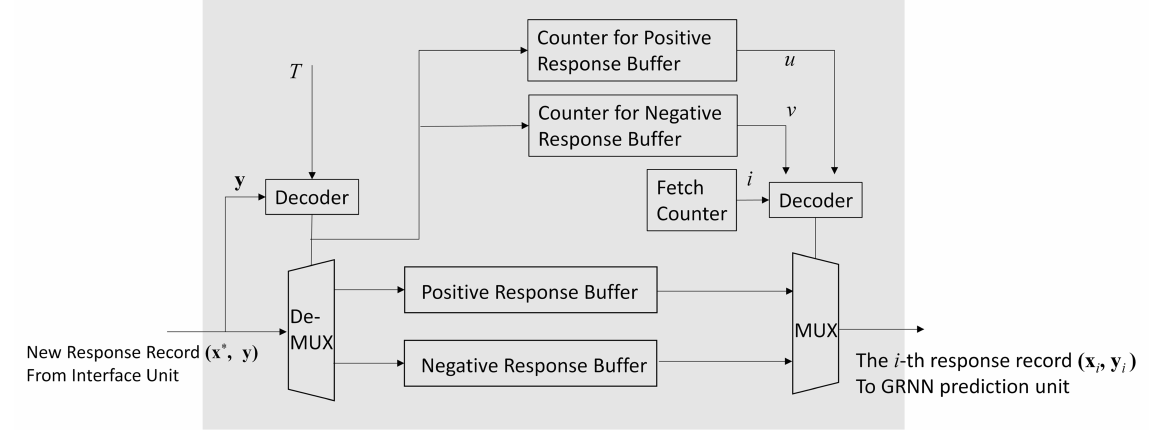
Figure 7. The architecture of the profile updating unit. In the architecture, both the positive response buffer and negative response buffer are used for storing response records in P